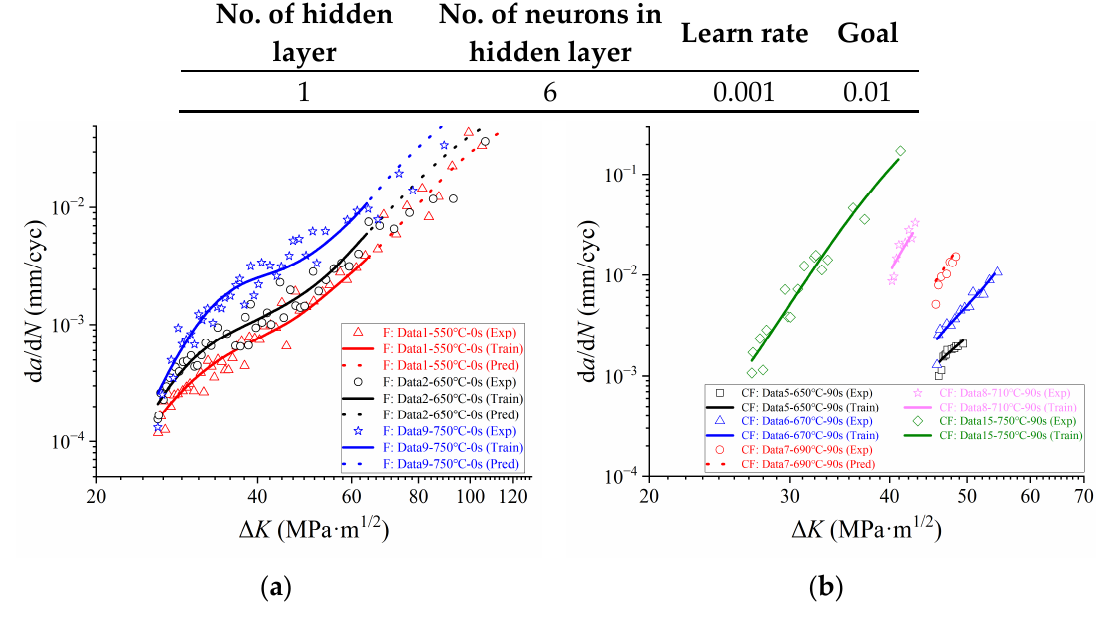
Figure 6. Prediction of the evolution of d a /d N with Δ K under ( a ) fatigue condition with different elevated temperatures (550/650/750 °C-0s-18/0.9 kN) and ( b ) creep-fatigue condition with different elevated temperatures (650–750 °C).